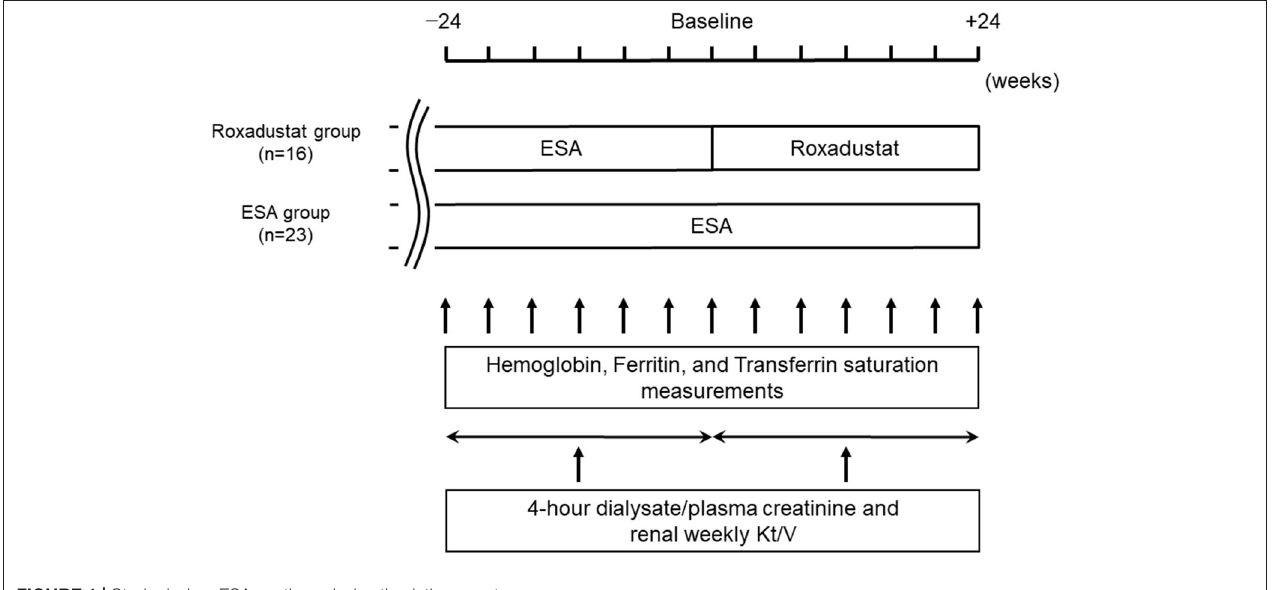
FIGURE 1 | Study design. ESA, erythropoiesis-stimulating agent.